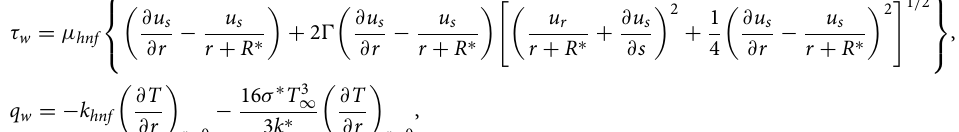
where the wall shear stress (τ w ) , and heat